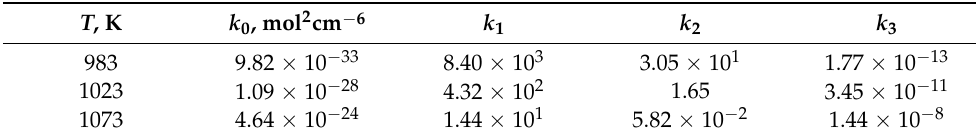
Figure 7. Experimental (symbols) and fitted (lines) dependences of the redox potential on the mole fraction of WO 3 in the Na 2 WO 4 –WO 3 melt. The curves have been shifted relative to each other to show them in one figure (the actual relative position of the experimental points is shown in Figure 3). The points that correspond to the standard melt 0.8Na 2 WO 4 –0.2WO 3 ( Δ E ( ν = 0.2) = 0) are marked with blank symbols. Table 1. Equilibrium constants of Reactions